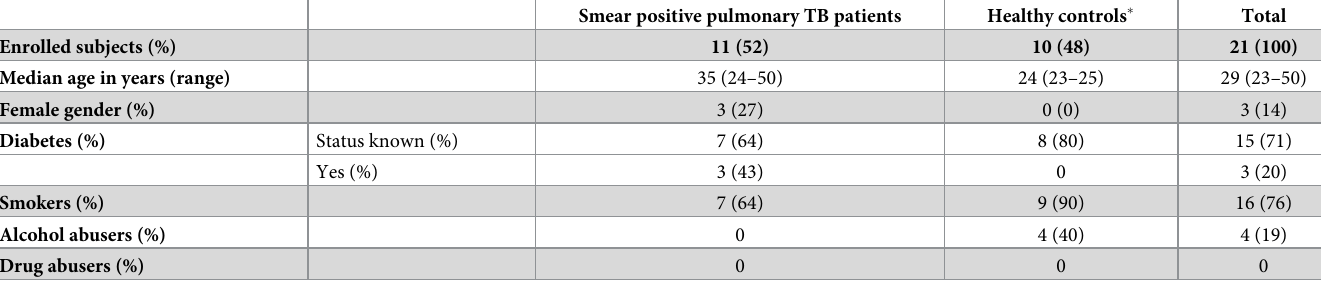
Table 5. Demographic characteristics of the subjects enrolled at the icddr,b, Dhaka, Bangladesh.